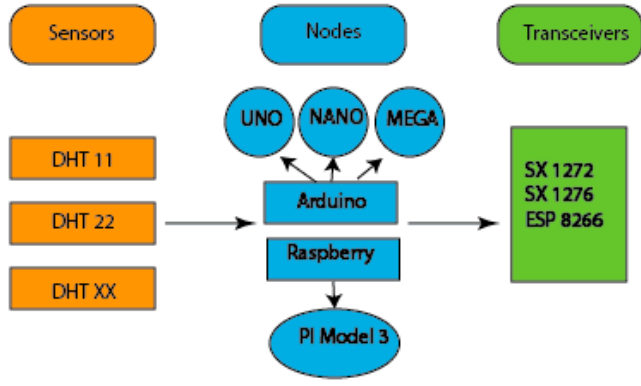
Figure 16. Sensors, end-nodes, and transceivers used in LoRa ecosystems.